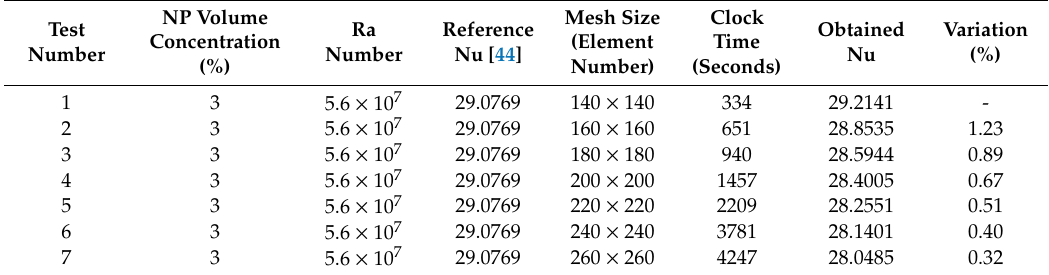
Table 3. Grid independency test of the present work.